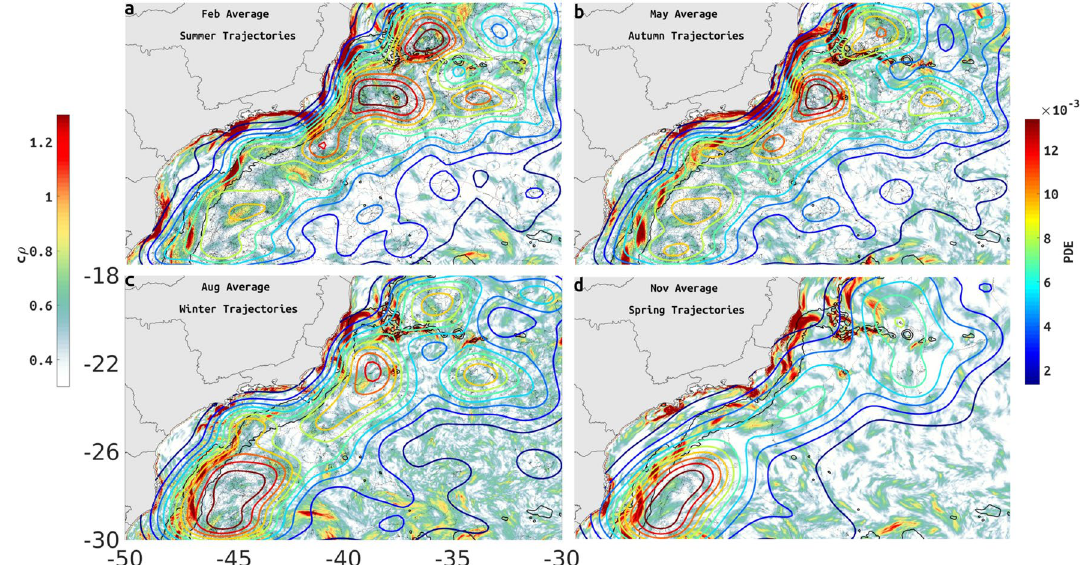
Figure 8. The PDE (coloured contours) of ( a ) all austral Summer trajectories (Jan–Feb–Mar) over the c ρ distribution for February (color shading), ( b ) all austral Autumn trajectories (Apr–May–Jun) over the c ρ values for May (color shading), ( c ) all austral Winter trajectories (Jul–Aug–Sep) over the c ρ values for August, and ( d ) all austral Spring trajectories (Oct–Nov–Dec) over the c ρ distribution for November. Depth contours of 200- and 2000-m are represented by black lines. Created with Matlab R2018B (www.mathw